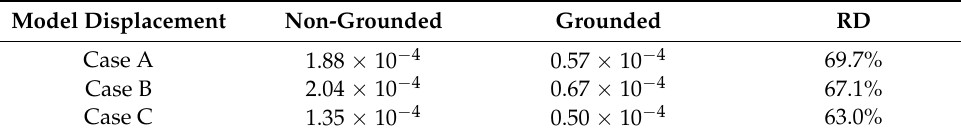
Table 4. Maximum ps SAR 10g (W/kg). RD refers to relative difference.